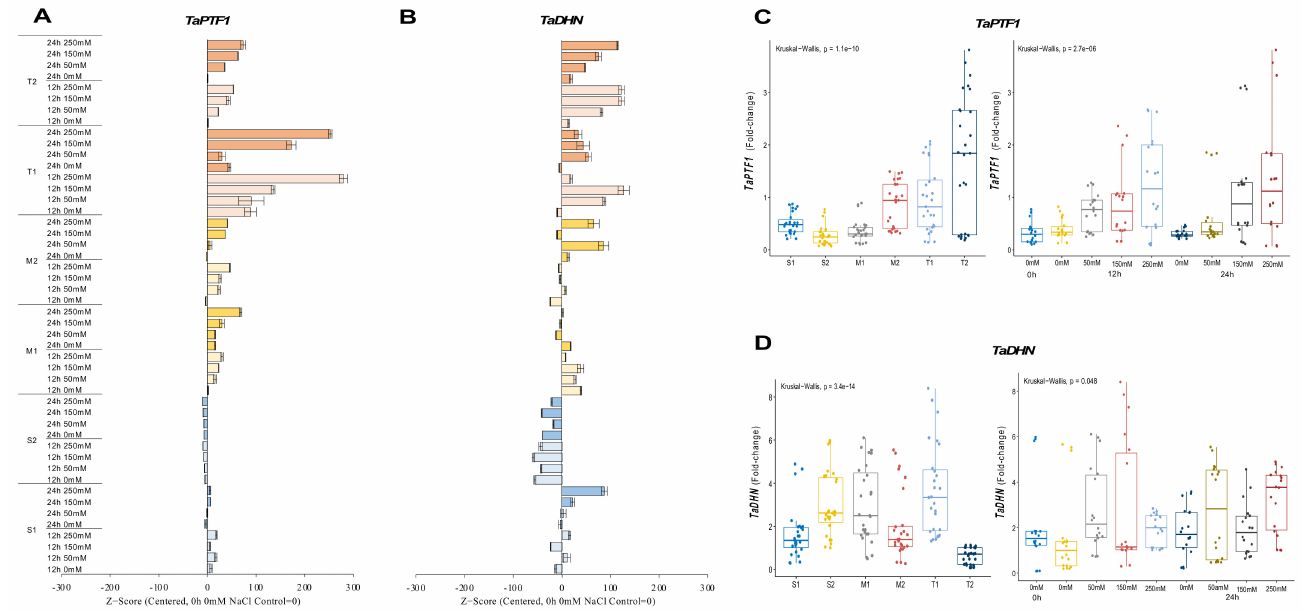
Figure 2. The expression of TaPTF1 and TaDHN genes. ( A ) The gene expression pattern of TaPTF1 and ( B ) TaDHN genes; ( C ) the total gene expression profile of TaPTF1 for genotypes, salt stress, and time course; ( D ) the total gene expression profile of TaDHN for genotypes, salt stress, and time course. The Cq values formed the basis of qRT-PCR. The reference gene TaACTIN was used to standardize the Cq value for each sample. Z-score centered to 0 h 0 mM treatment (Control = 0). Values represent the means ± SD ( n =